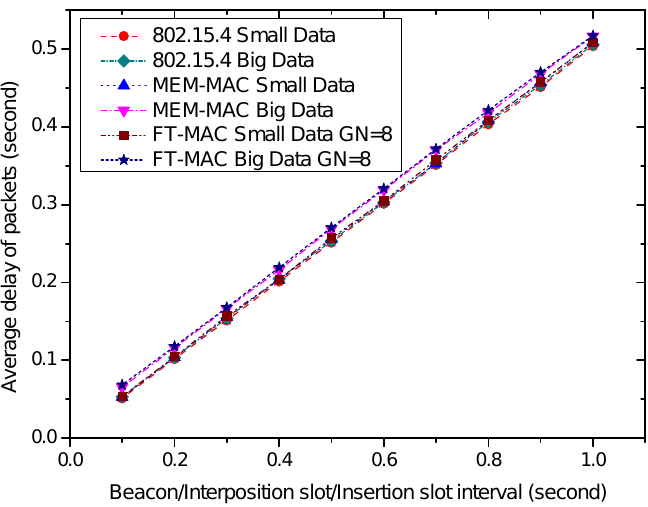
Figure 20. The enlarged part of Figure 17 from 0.1 s to 1.0